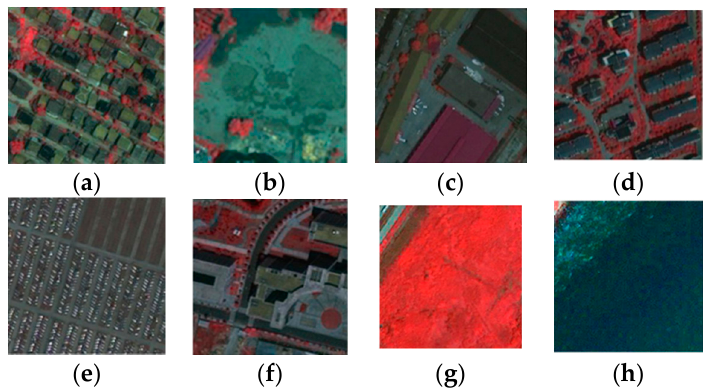
Figure 12. Wuhan IKONOS large image and its scene understanding result: ( a ) the original image; and ( b ) the scene understanding result.